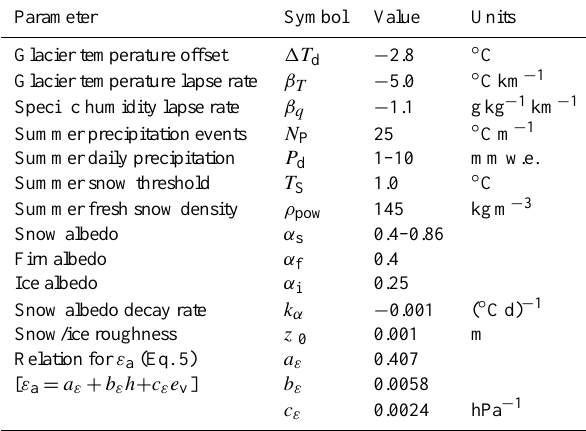
Table 2. Parameters in the distributed energy balance and melt